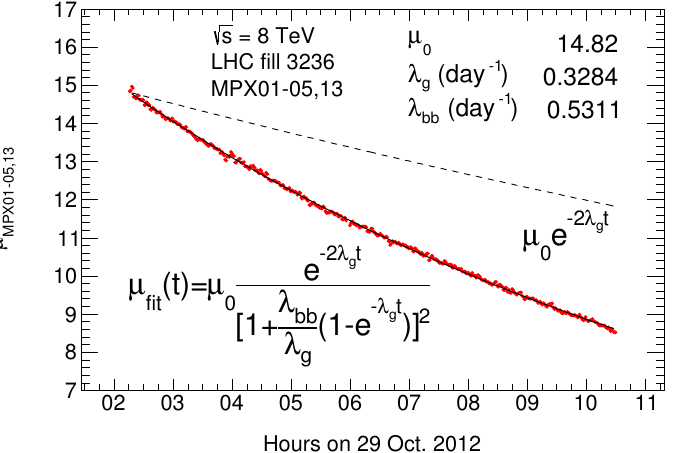
Figure 13. Average number of interactions per bunch crossing as a function of time using combined data from MPX01-05 and MPX13. The distribution is approximately described by the function given in the figure. The parameters are defined in the text. In addition to the fit result described by the thin line, the dashed line shows the result of beam–gas interactions alone µ 0 exp ( − 2 λ g t ) , with µ 0 and λ g obtained from the three-parameter fit. LHC fill 3236.Taken from Ref.